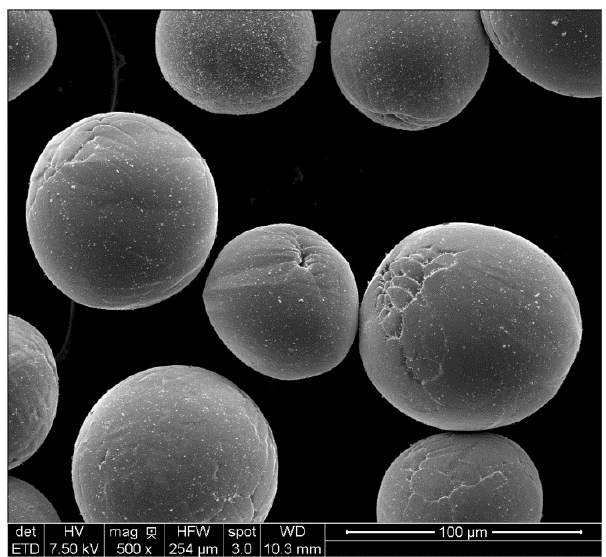
Figure 6. Titanium spherical powder formed using plasma atomization of